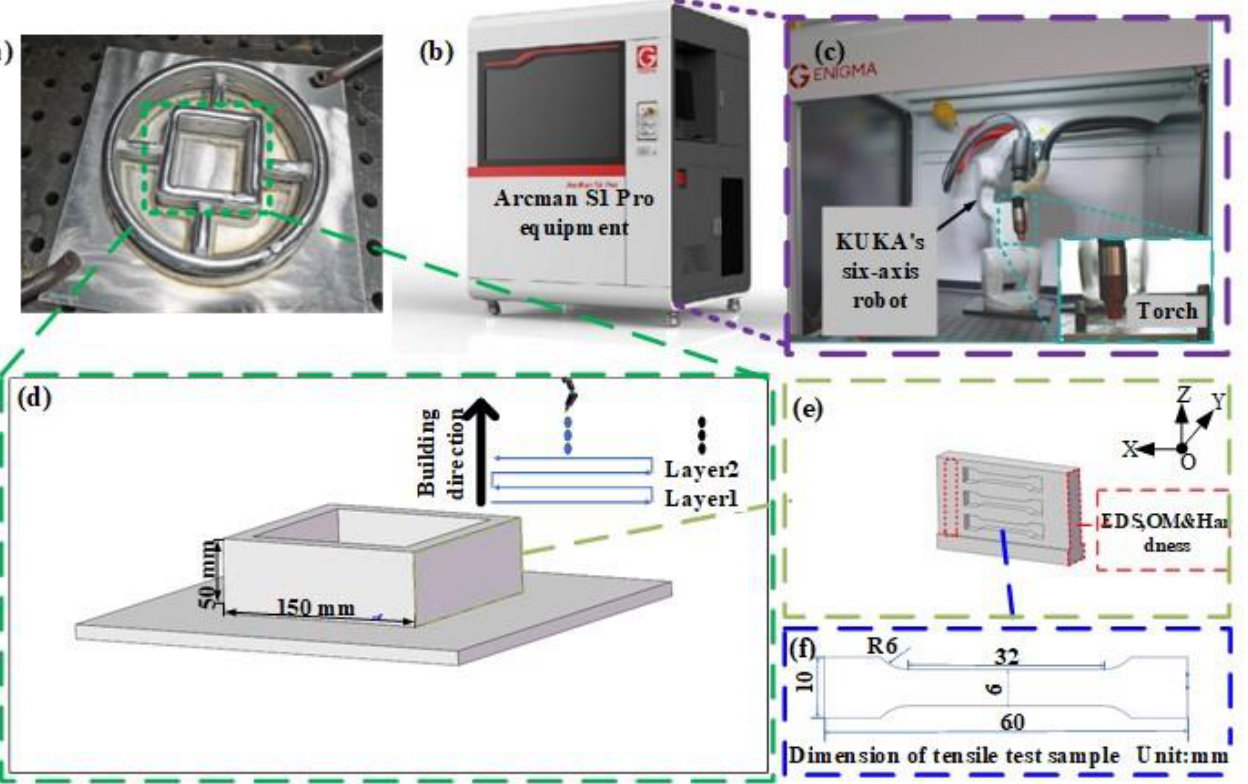
Figure 1. WAAM process schematic: ( a ) physical diagram of the formed part; ( b ) additive manufacturing equipment; ( c ) picture of the inside of ( b ); ( d , e ) EDS, OM, and microhardness sampling diagrams; and ( f ) dimensions of the tensile test sample.